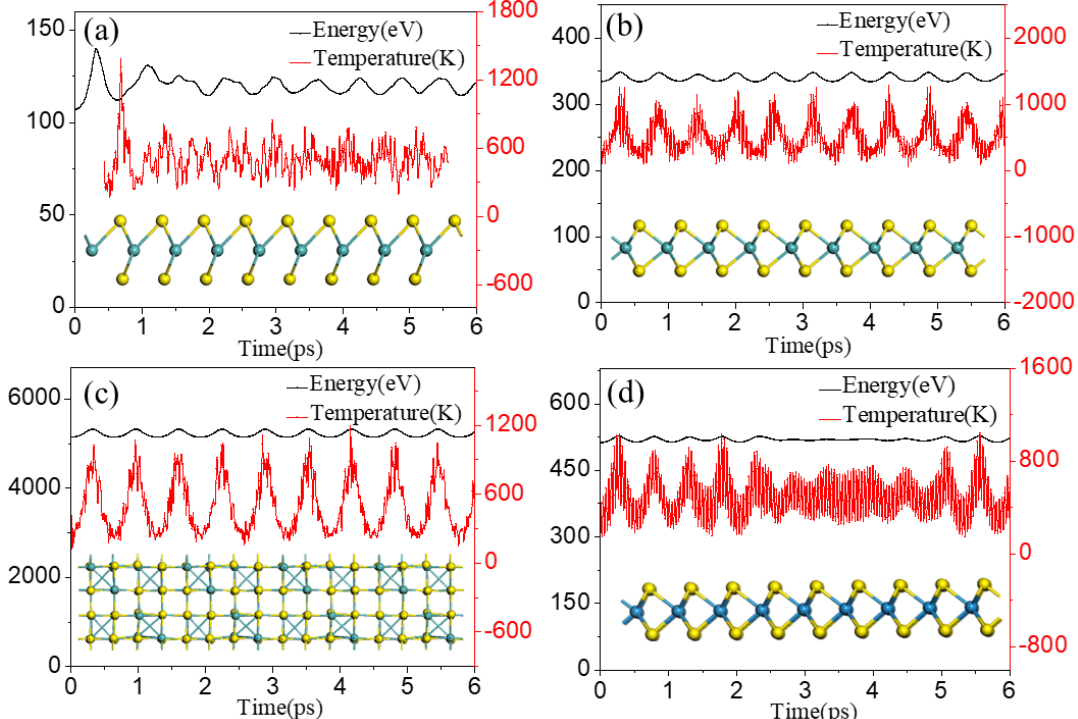
Figure 6. Structural snapshots (side view) of the ( a ) MoS 2 (space group R3m) ( b ) MoS 2 (space group P6 3 /mmc) ( c ) MoS 2 (space group F43m) and ( d ) WS 2 (space group R3m), with the evolution of mean potential energy and temperature per atom in MD (molecular dynamics) simulations at 500 K and 6 ps.